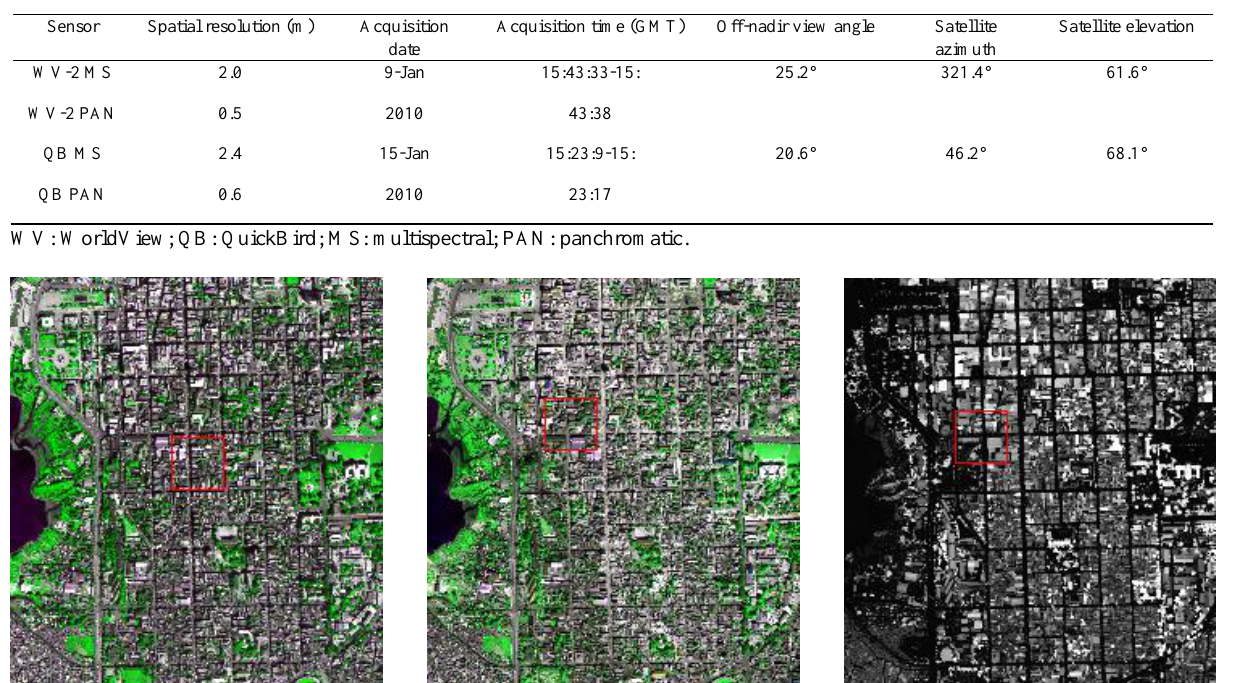
Table 1. DATA CHARACTERISTICS AND SATELLITE POSITION INFORMATION FOR BOTH DATASETS